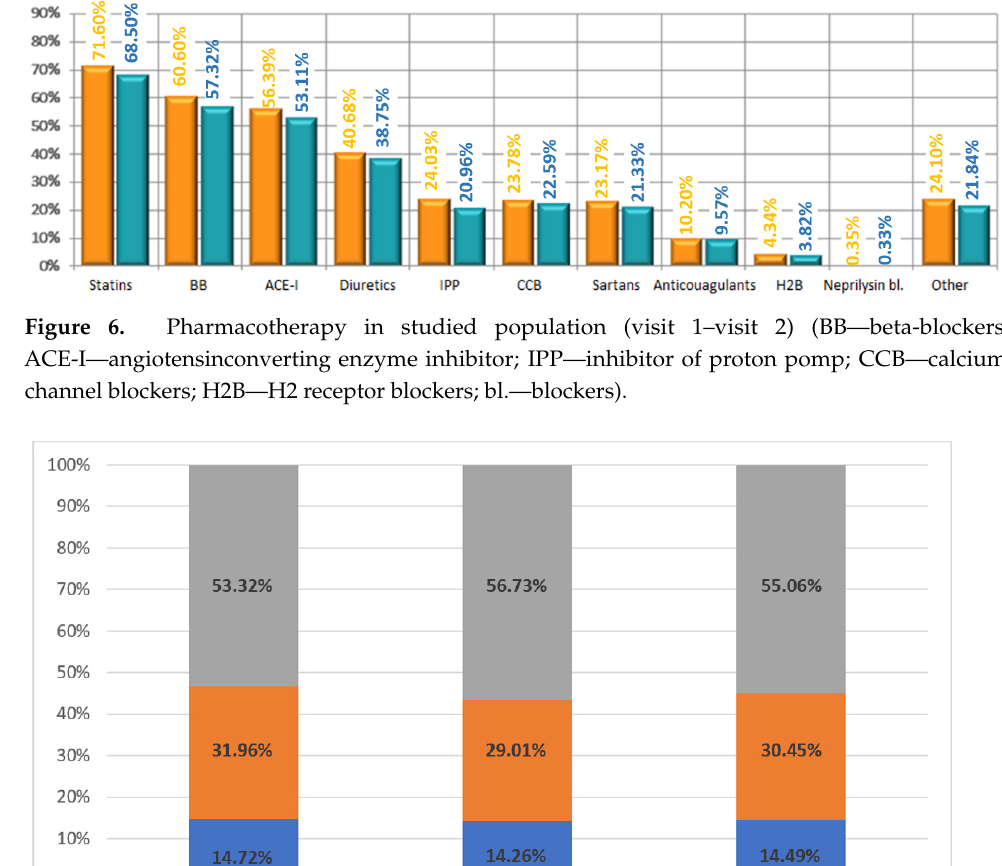
Figure 5. Comorbidities (IHD—ischemic heart disease; HF—heart failure; AF—atrial fibrillation; PAD—peripheral arterial disease; DM—diabetes mellitus; COPD—chronic obstructive pulmonary disease).